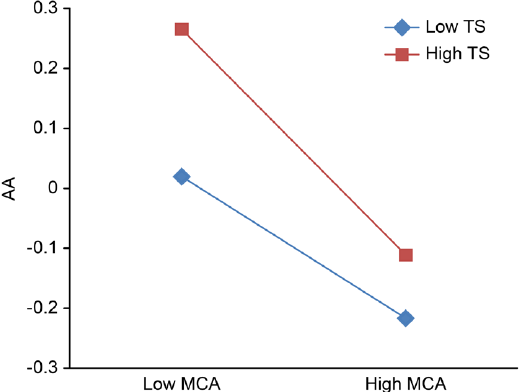
Figure 4. Peer support adjustment chart a. MCA, mother-adolescent attachment; TS, teacher support; AA, adolescent anxiety.